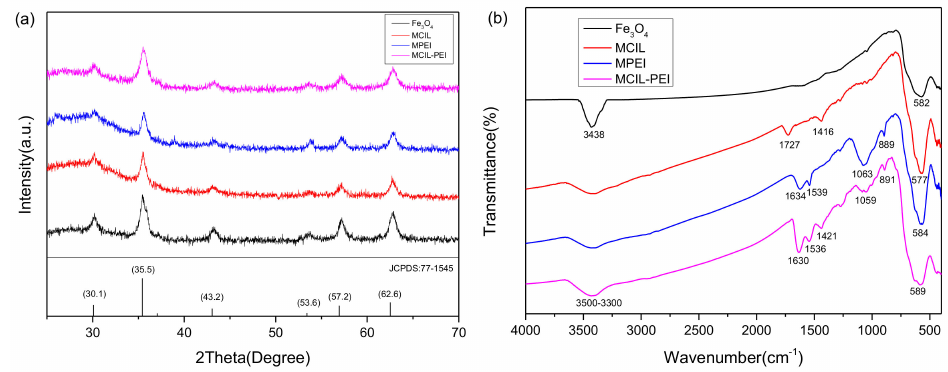
Figure 1. XRD pattern ( a ) and FT-IR spectra ( b ) of